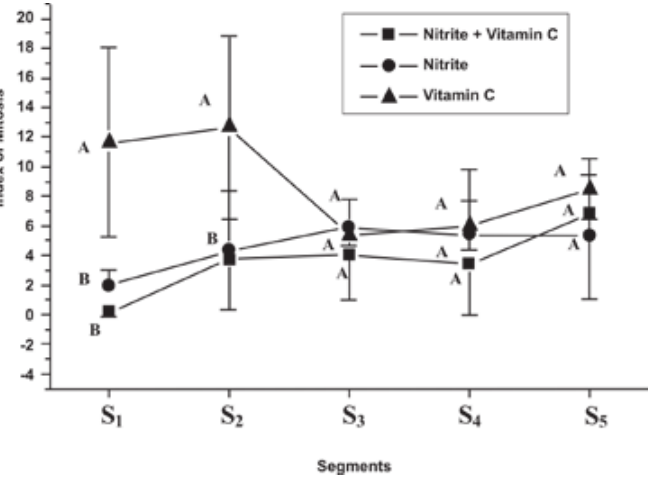
FIGURE 5 - Means and standard deviations of the Index of Mitosis according to group and treatment.